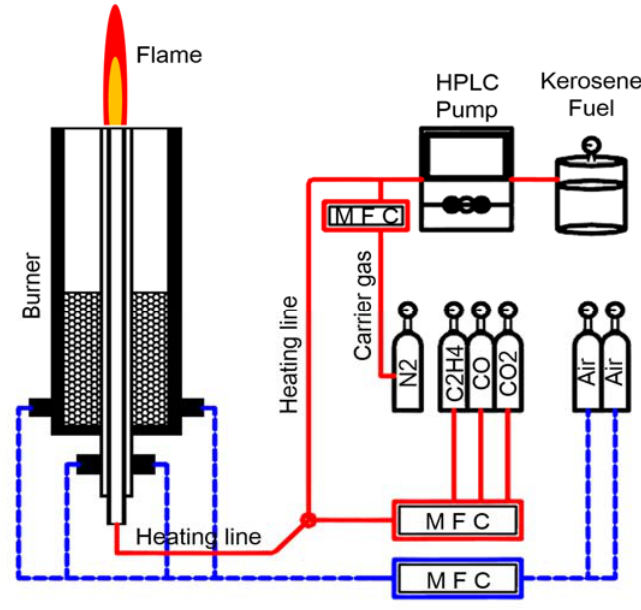
Figure 1. Schematic of coflow burner and vaporizer apparatus.